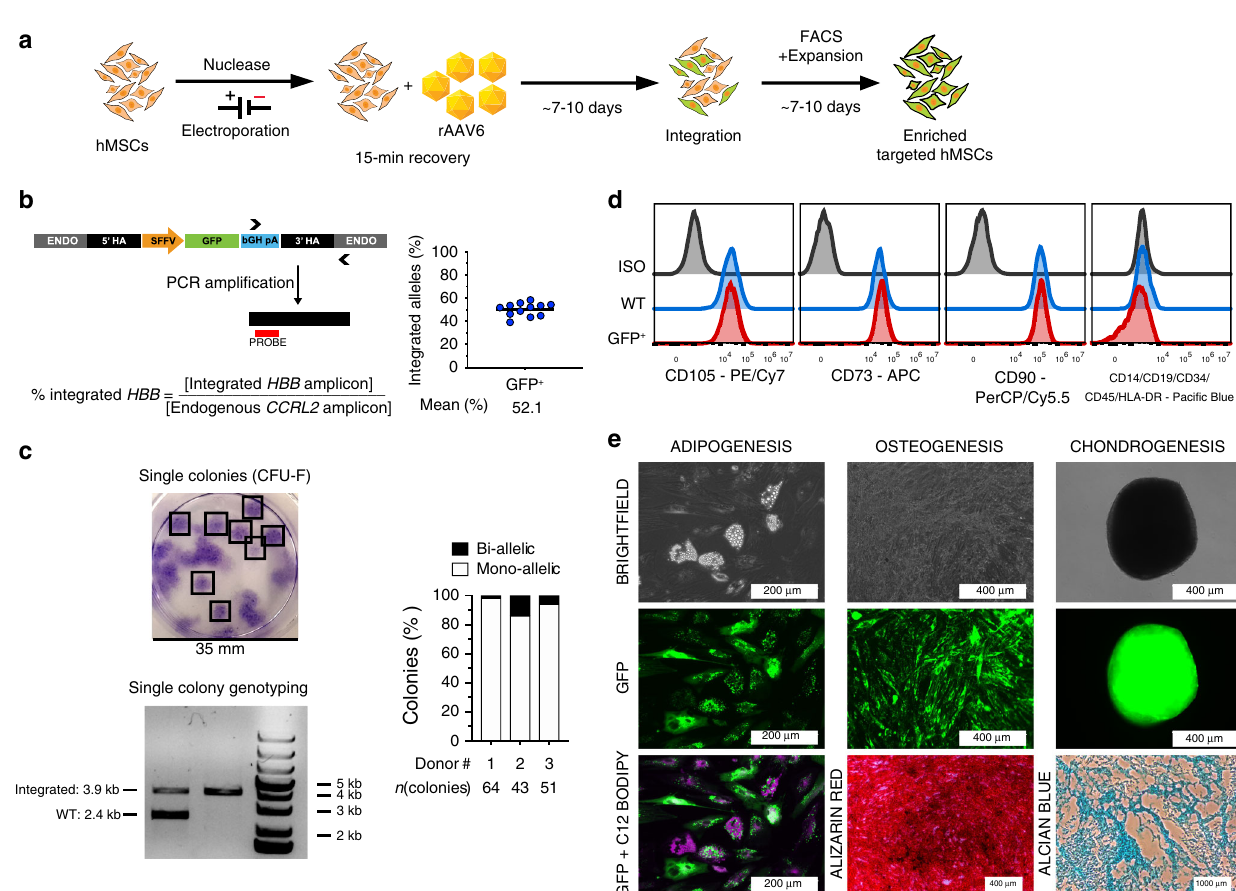
Fig. 2 Genome-editing procedures and gene integration at HBB preserved ex vivo hMSC characteristics. a HBB -targeted GFP + population of hMSCs were enriched by FACS for genotypic and phenotypic characterization. b Genomic DNA of the GFP + population was subjected to digital droplet PCR-based quanti fi cation of transgene-integrated HBB alleles. Absolute quanti fi cation of integrated allele was normalized to that of endogenous CCRL2 locus. Plot represents fraction of integrated alleles in sorted GFP high hMSC population (biological replicates: n = 12) targeted with either All-RNA or RNP nucleases and AAV donors. c (Top left) Representative image shows crystal violet staining of colony-forming units (CFU-F). Boxes enclose single colonies. (Bottom left) Representative agarose gel image shows size-separation of integrated and non-integrated HBB amplicons. Genotyping is repeated in parallel PCR reactions for each colony derived from three different hMSC donors, which yielded similar amplicon distribution as a result of gel electrophoresis. (Right) Plot represents frequency of colonies with mono-allelic and bi-allelic integration genotypes in three different biological hMSC donors. Numbers of colonies screened for each donor is listed underneath the plot as n (colonies). d Staggered histograms show representative distribution of CD105, CD73, and CD90 expression level and the lack of hematopoietic markers expression on the surface of sorted GFP + hMSCs compared to wild-type cells (WT) and isotype controls (ISO). e Representative image panel represents morphology (bright fi eld), GFP expression (green), and characteristic staining of differentiated sorted GFP + hMSCs. Accumulated lipid droplets in adipogenic differentiation were stained with C12-BODIPY or LipidTOX ® stains (magenta). Calcium deposition in osteogenic differentiation was con fi rmed with Alizarin Red staining. Chondrogenesis was con fi rmed with pellet formation and Alcian Blue staining of pellet sections. Distances are indicated by scale bars. Tri-lineage differentiation potential is con fi rmed in all hMSCs derived from 12 different donors. Source data are available in the Source data fi